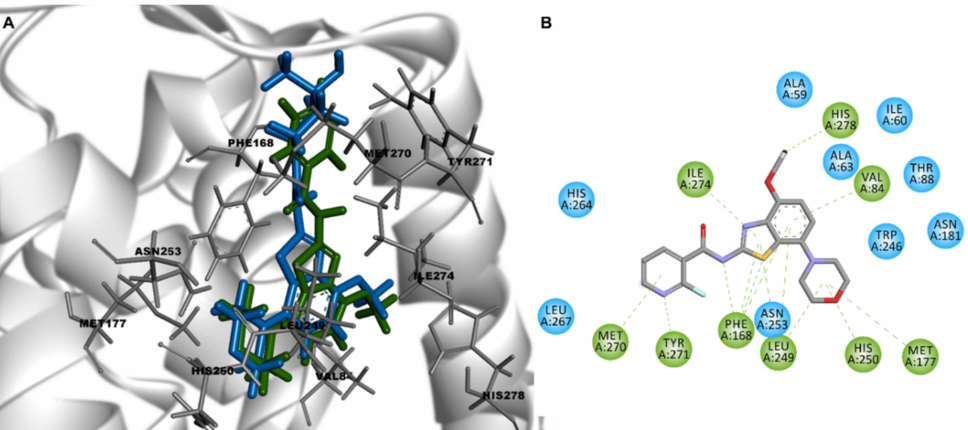
Figure 3. ( A ) Overlay of the docking poses of tozadenant (blue) and TOZ1 (green) in the binding site of crystal structure of A 2A R (Protein Data Bank (PDB) ID: 4EIY) and ( B ) 2D interaction diagram of TOZ1 with key interactions in